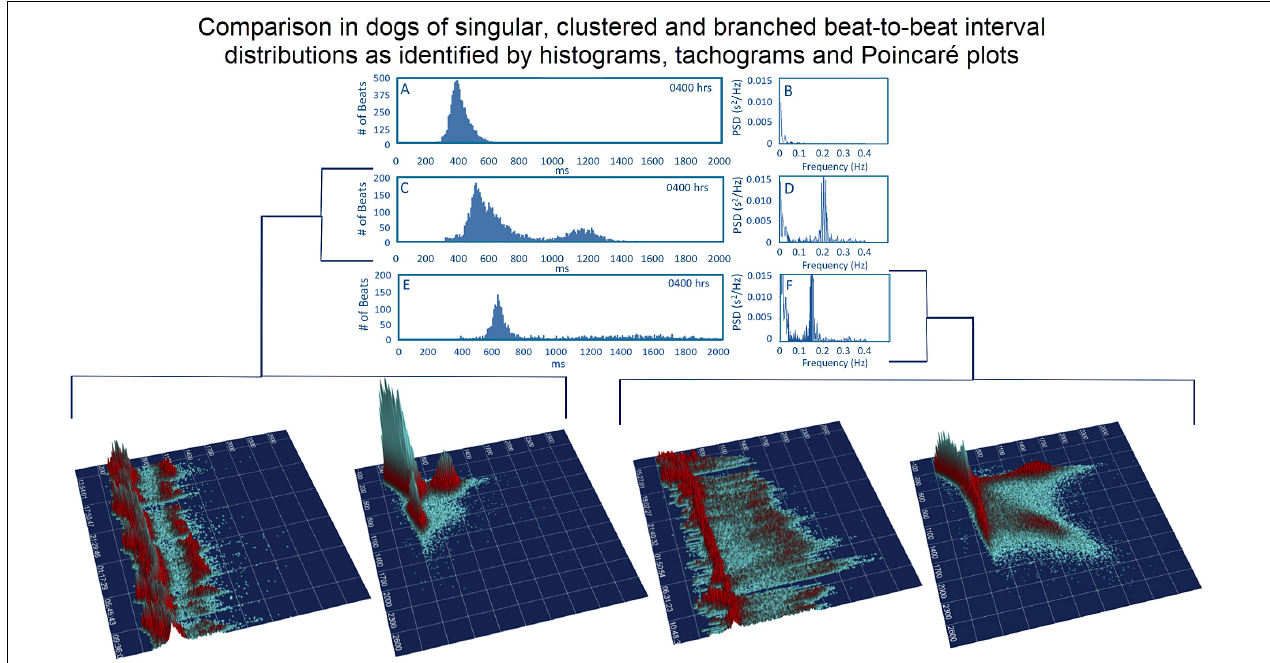
FIGURE 8 | To assist in understanding some of the geometric patterns identified in the dog analyses were performed after visual inspection to categorize major beat-to-beat patterns. Initially, the hourly R–R interval histograms were inspected to identify those with a single Gaussian-shaped distributions and those with two or more distributions apparent that also had a region with a paucity of beats (Frames A,C,E ). Statistics regarding time domain and frequency domain characteristics are provided in Table 2 . In this figure, examples of the two-dimensional histogram and corresponding power spectrum/frequency domain profile of heart rate variability (Frames B,D,F ) are shown. The three-dimensional R–R interval tachograms and histographic Poincaré plots for the two different dogs shown in frames (C,D) and frames (E,F) are bracketed below. Each of these dogs was a